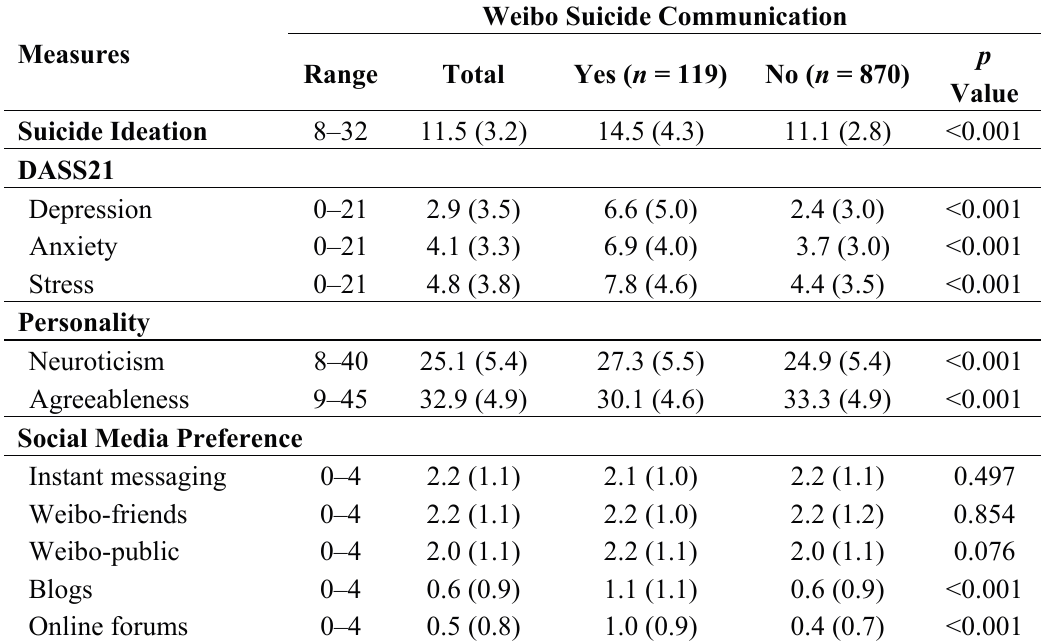
Table 2. Means (standard deviation) of observed variables and items and Mann-Whitney- Wilcoxon tests between groups.